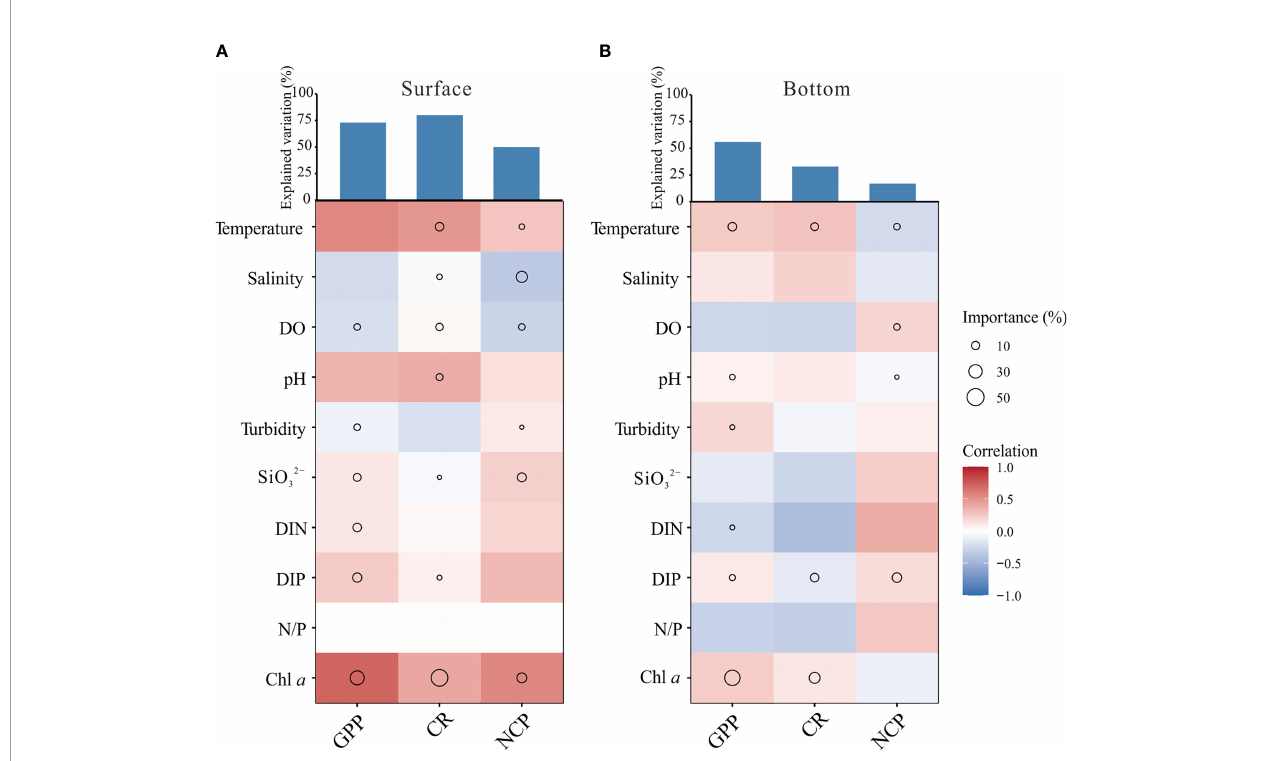
FIGURE 7 | Contribution of environmental factors to variation of GPP, CR, and NCP based on optimal multiple regression model in (A) surface and (B) bottom layers. The above bar graph indicates the total contribution, and the heat plot indicates the Spearman correlation coef fi cients. The size of circles indicates the importance of environmental